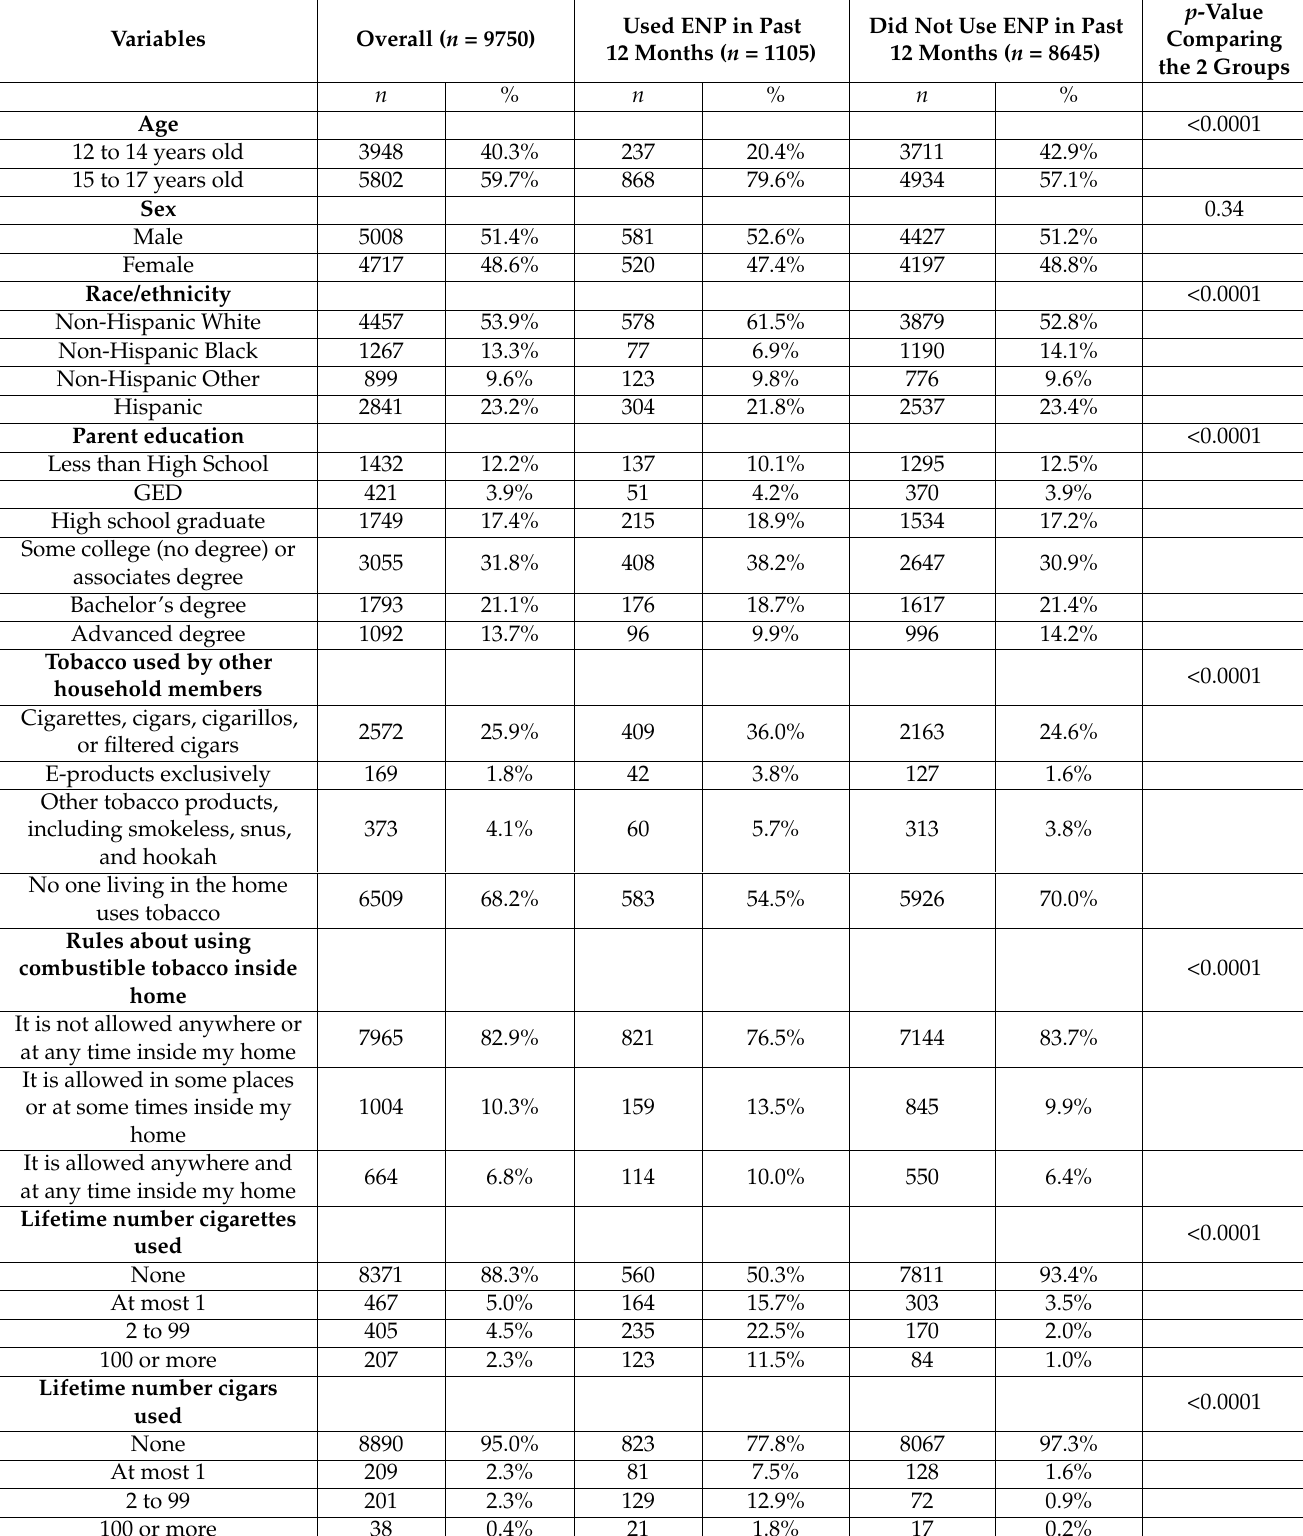
Table 1. Descriptive statistics of PATH Wave 3 continuing youth overall and by electronic nicotine product use in past 12